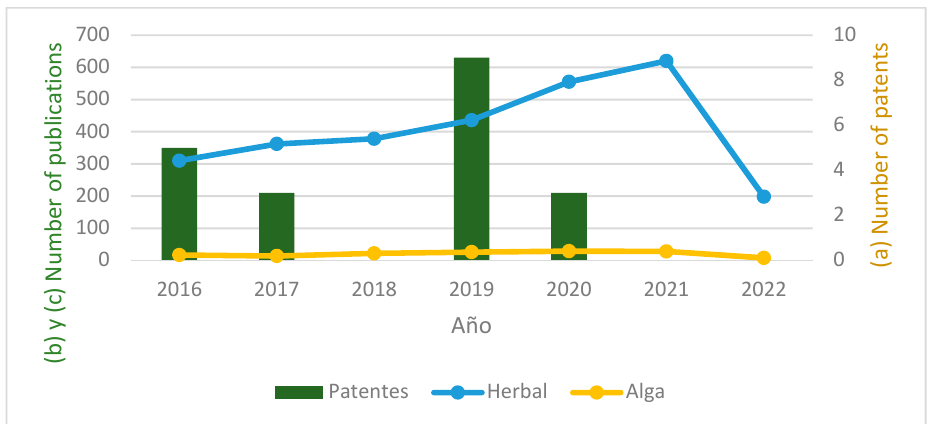
Figure 4. (a) Number of patents with IPC classification A61K36/00 published between period 01/2016 and 04/2022. (b) Number of articles published in PubMed between 01/2016 and 04/2022 associated with diabetes and herbal preparations. (c) Number of articles published in PubMed between 01/2016 and 04/2022 associated with diabetes and algae-based preparations.